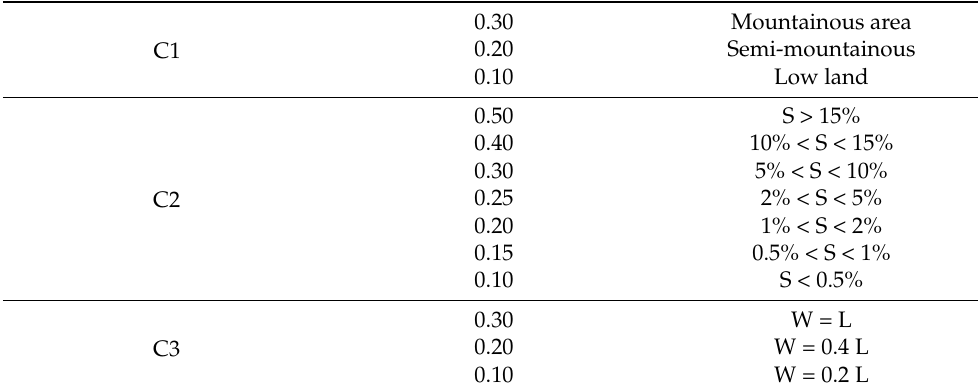
Table 1. Values of C1, C2 and C3 [21].